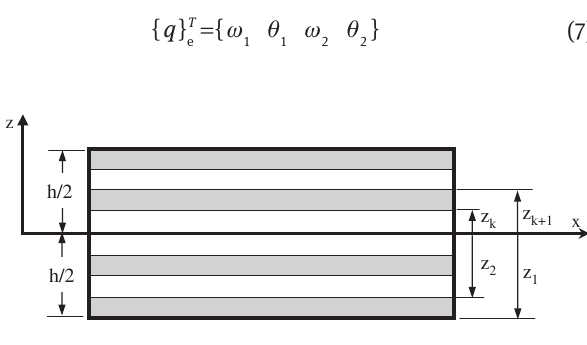
Figure 2 Coordinate locations of plies in laminated composite beam.